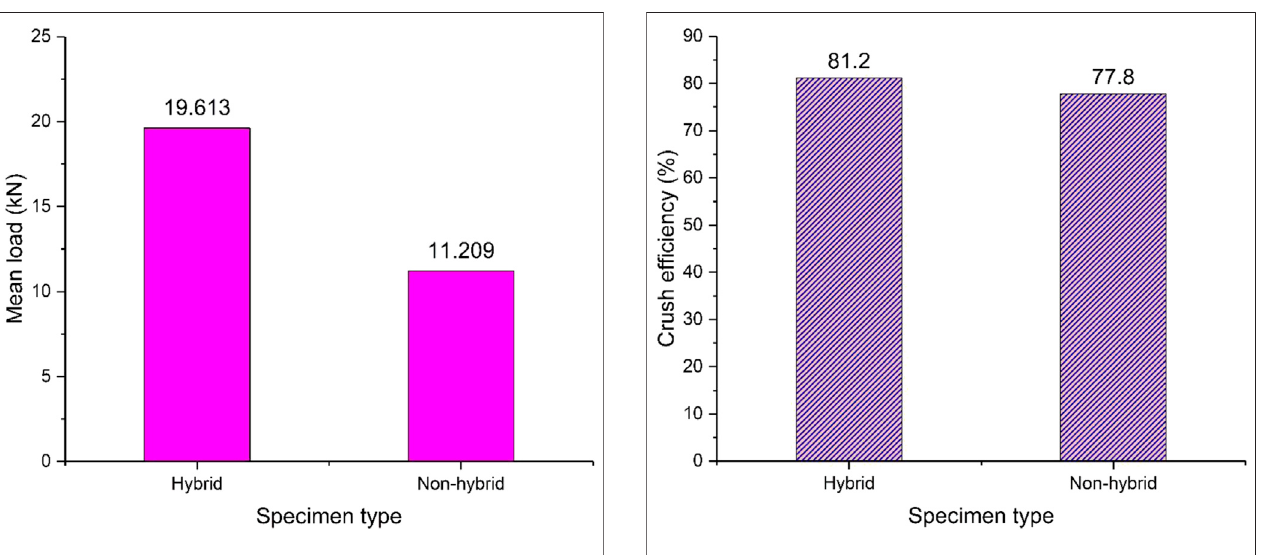
FIGURE 6 | A comparison of P m between hybrid and nonhybrid composite specimen.